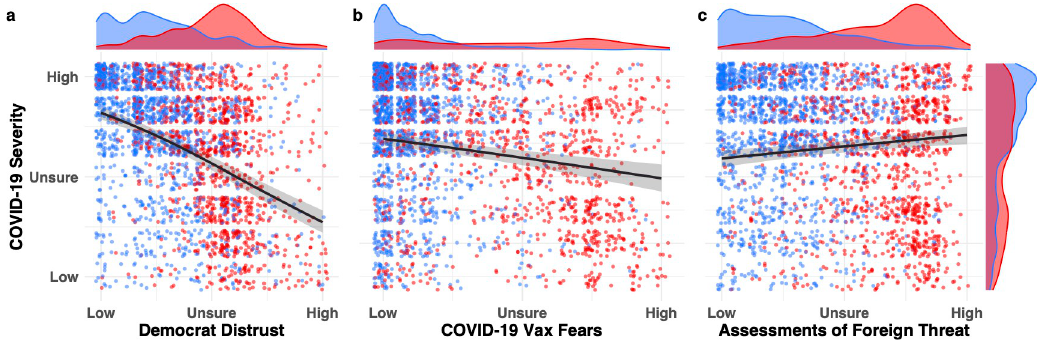
Fig 3. Histograms of three strongest predictors of prewave COVID-19 skepticism and their relation to political ideology. Regression lines represent effect size estimates conditioned on the average response for the remaining predictors in the maximal model. Error regions represent 95% credible intervals (the interior 95% of the posterior distribution for the effect size). Participant-level averaged responses on the scales for those who identified as socially liberal (blue) and conservative (red) are jittered with kernel density plots representing the distribution of responses for each predictor. Responses of participants who identified as moderate were excluded from visualization but were included in the model. Horizontal density functions at top of each panel summarize distribution of responses by Democrats and Republicans on each predictor variable; vertical density functions at right summarize distribution of responses on the COVID-19 severity scale.